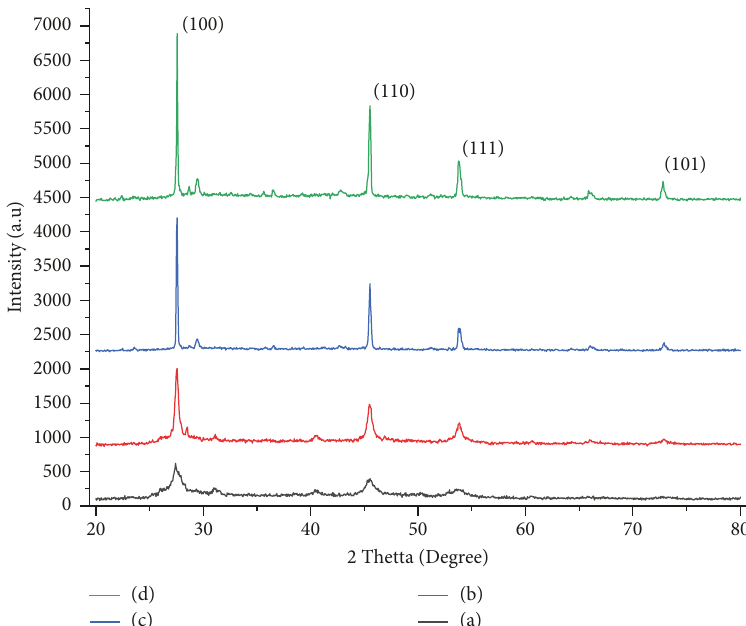
2, (b) pH 4, (c) pH 5, and (d) pH 6. (cid:31) (cid:31) (cid:31) (cid:31) 2 NPs at different pH values (2, 4,